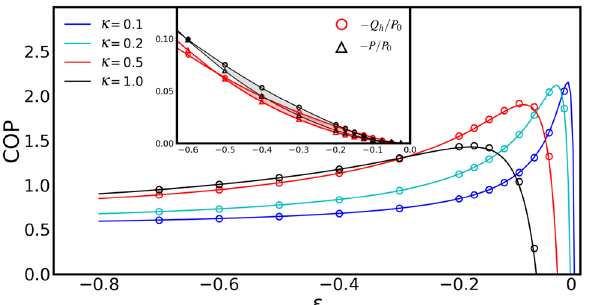
Figure 4. The main figure shows the coefficient of performance of a Brownian magneto-refrigerator with T h / T c = 1.1 , and M = 1.0 , α = 4.0 as a function of the force strength ε for different values of the diffusive Hall parameter κ . The sign of the force strength ε is such that the resulting torque in the z direction is along the same direction as the torque due to the applied magnetic field. The COP of the refrigerator has a maximum for each value of κ . The inset shows the average rate of the heat absorbed by the hot bath and the corresponding input power where P 0 = k ( T c + T h )/γ . The red and gray shaded regions correspond to a refrigerator with COP > 1 for κ = 0.5 and κ = 1.0 , respectively. The solid lines are from our theoretical predictions and the symbols depict the simulation